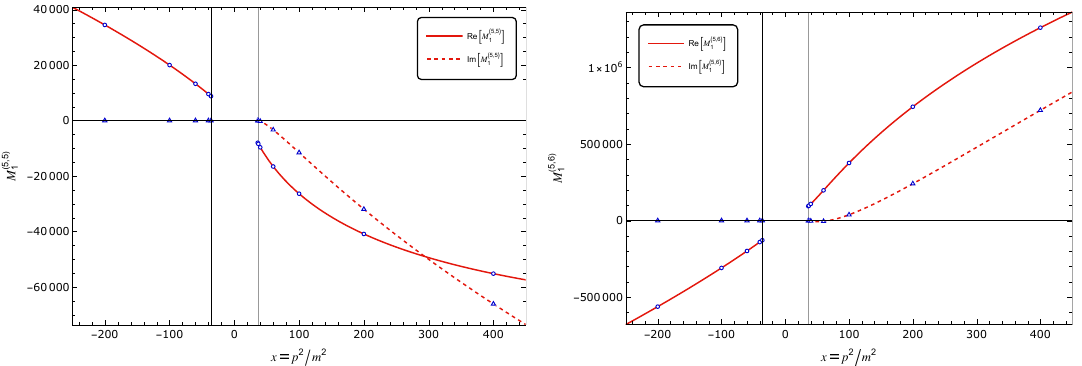
Figure 2 . Comparison of our result for M (5 , 5)